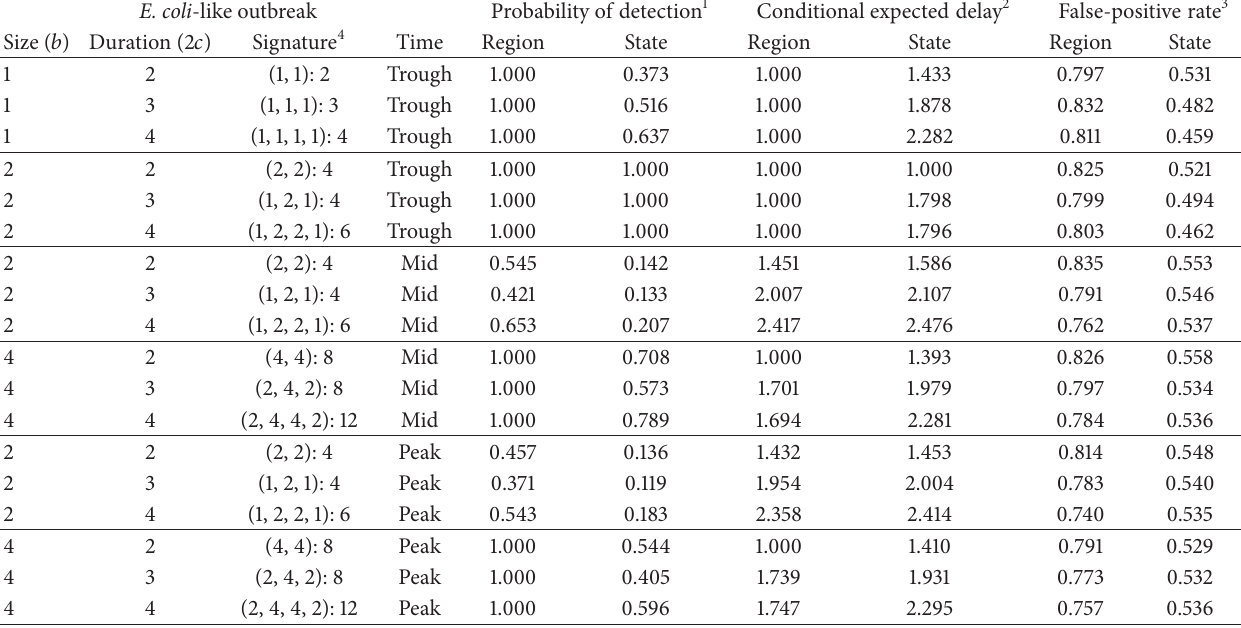
Table 2: Simulation results for E. coli O157:H7 infection outbreaks assuming Poisson model.